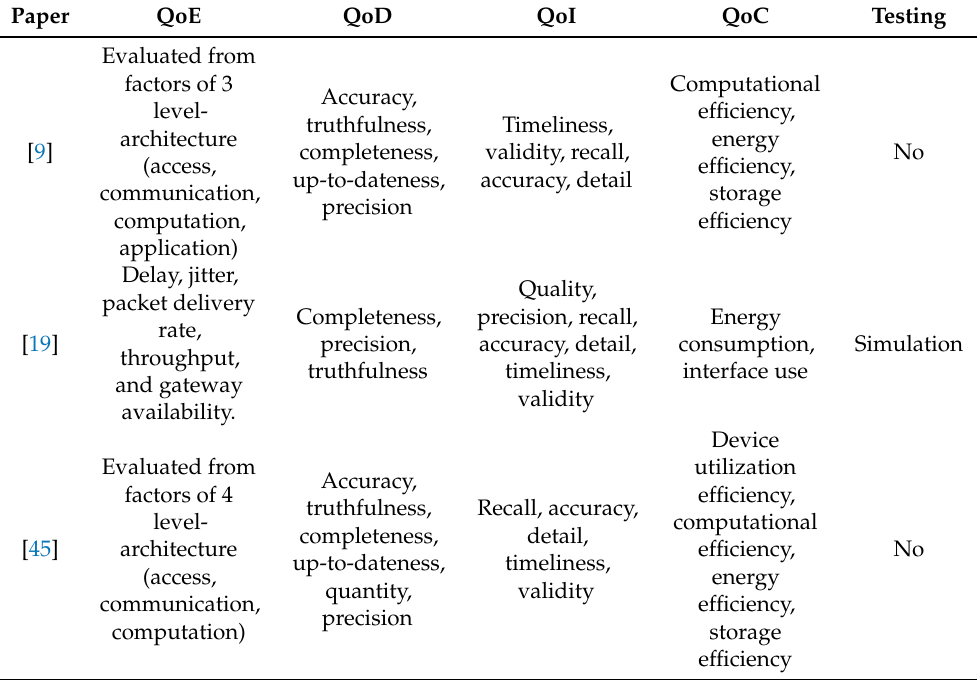
Table 6. Generic QoE calculations